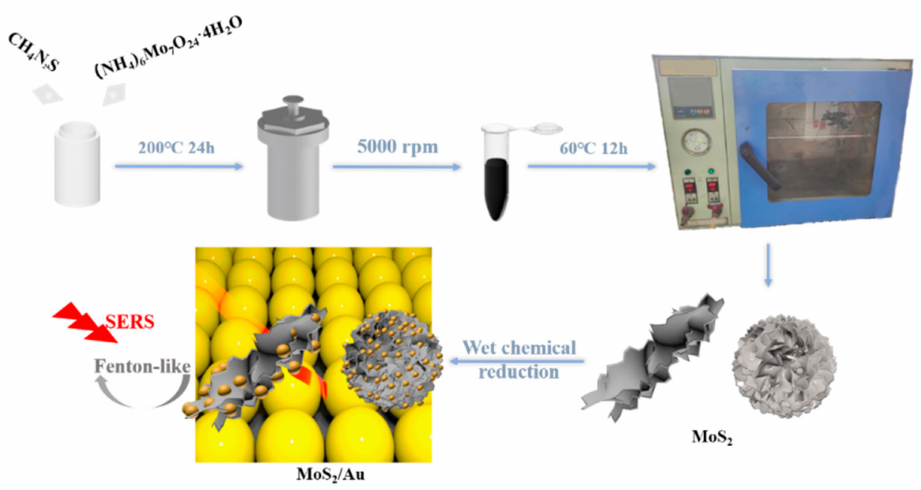
Scheme 1. Schematic illustration of layered MoS 2 and MoS 2 /Au heterojunctions preparation